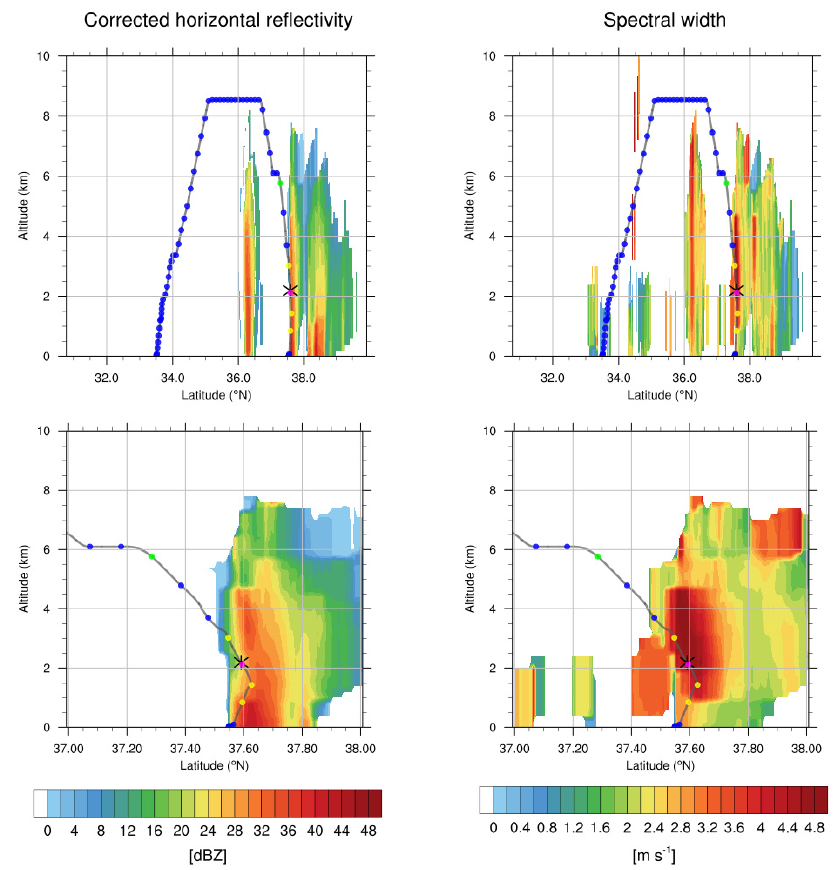
Figure 6. (Left) Latitude–altitude cross-sections of radar reflectivity and (right) SW centered on the longitude of Table 126.64° E at 05:40 UTC on 28 October 2018. Bottom panels are magnifications of the accident region of the latitude of 37–38° N. The location of the turbulence encounter is indicated by the black asterisk, and waypoints along the flight route are indicated by the colored dots according to the EDR values (blue: NIL, green: LGT, yellow: MOD, and pink: SEV).